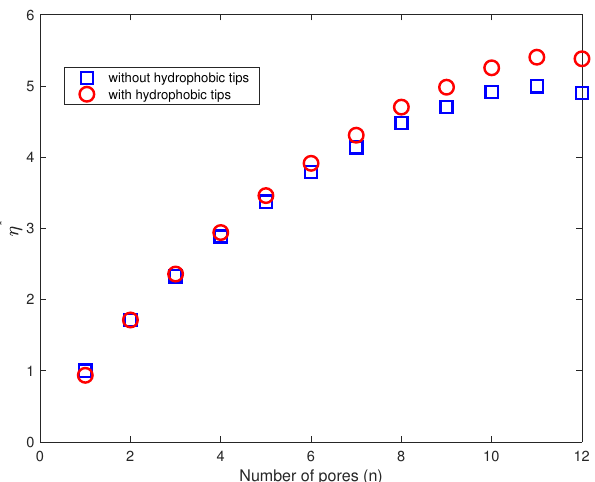
Figure 14. Overall efficiency of multiple pores with hydrophobic sections: blue squares represent the case without any hydrophobic sections; red circles represent the case with hydrophobic sections; the wall temperature is set as 0.72 for both cases; efficiency is normalized with respect to the case that there is only one purely hydrophilic pore.